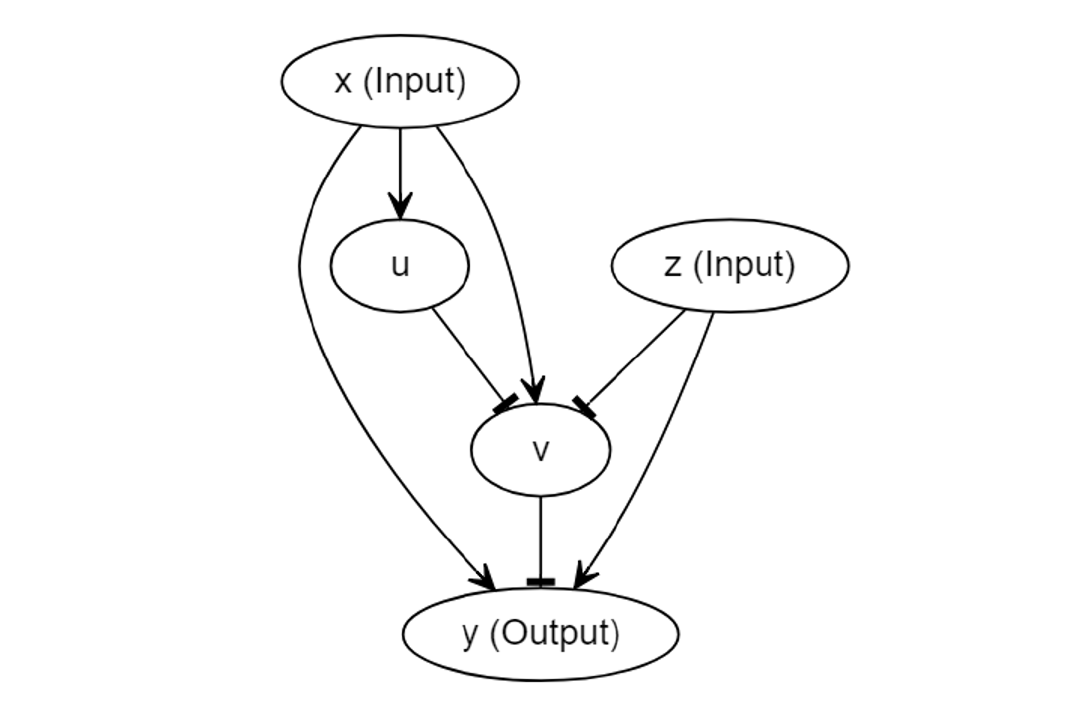
Figure 2. The schematic circuit of the model with forced